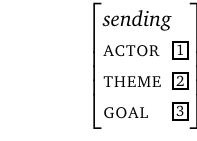
Figure 5: Simple role frames for eating and sending